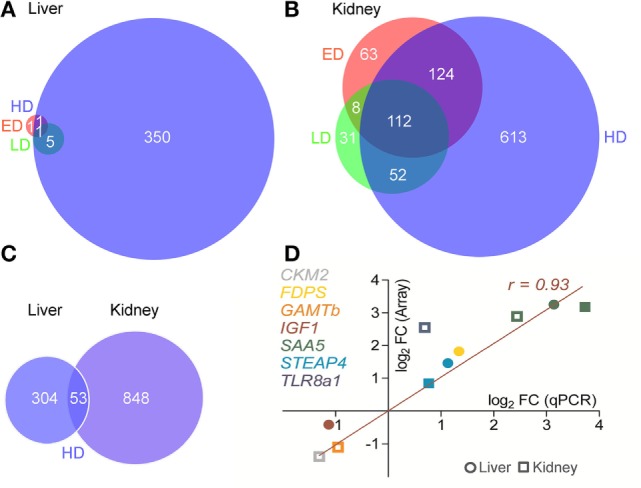
Venn diagrams show the overlap in differentially expressed genes at different stocking densities (SDs) in the (A) liver and (B) kidney of maraena whitefish kept at low density (green), elevated density (ED) (red), and high density (HD) (blue) each compared with moderate density (MD) conditions. The intersections indicate the number of genes affected by more than one SD. Criteria for significance were a total fold change (FC) > 1.5 and a corrected p < 0.05 of annotated, non-redundant features. (C) In a subsequent analysis, the sets of differentially expressed genes of HD vs. MD treatment were compared between liver and kidney. (D) The concordance of array (ordinate) and quantitative real-time PCR (abscissa) FC values for selected genes (as listed on the right) were plotted for ED vs. MD (open symbols) and HD vs. MD (filled) comparisons in the liver (circular) or kidney (squared). Pearson’s correlation is indicated.